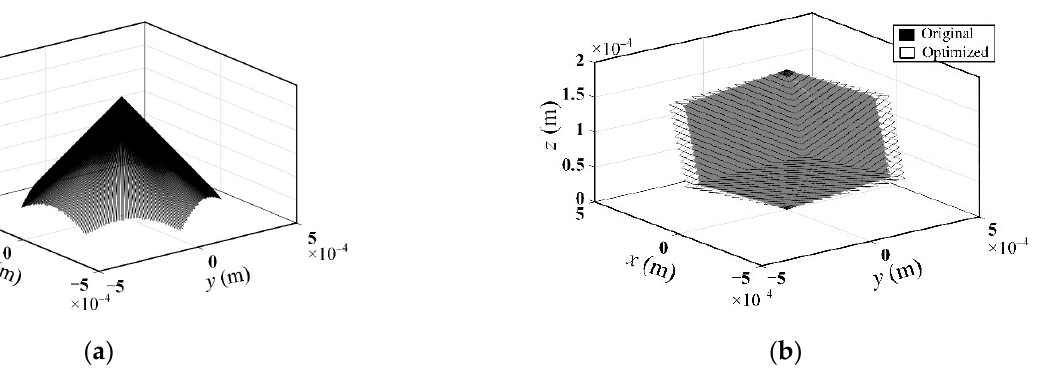
Figure 10. ( a ) The dexterity within the maximum cross-section of the workspace of the optimized mechanism; ( b ) workspace comparison between original and optimized designs.